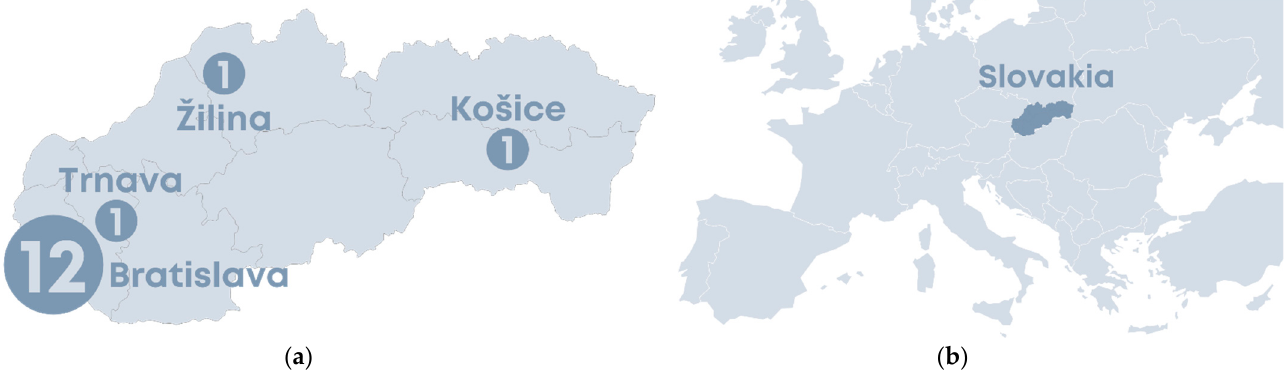
Figure 2. ( a ) Map of Slovakia with the number of respondents and name of the cities where the headquarters of the companies are located. ( b ) Map of Europe highlighting Slovakia.